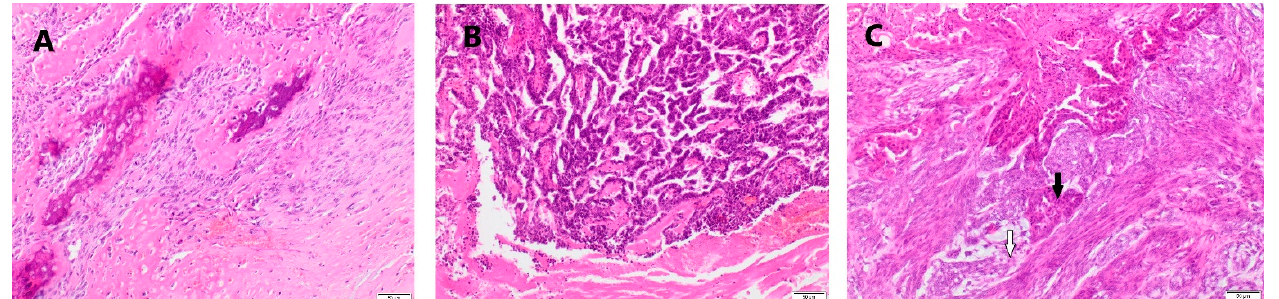
Figure 1. Representative histopathological photomicrographs of ( A ) osteosarcoma, ( B ) tubular carcinoma grade 2, and ( C ) complex carcinoma grade 2–obliterating of glandular structure (black arrow) and myoepithelial cells (white arrow) are present. HE staining. Magn. 100×.